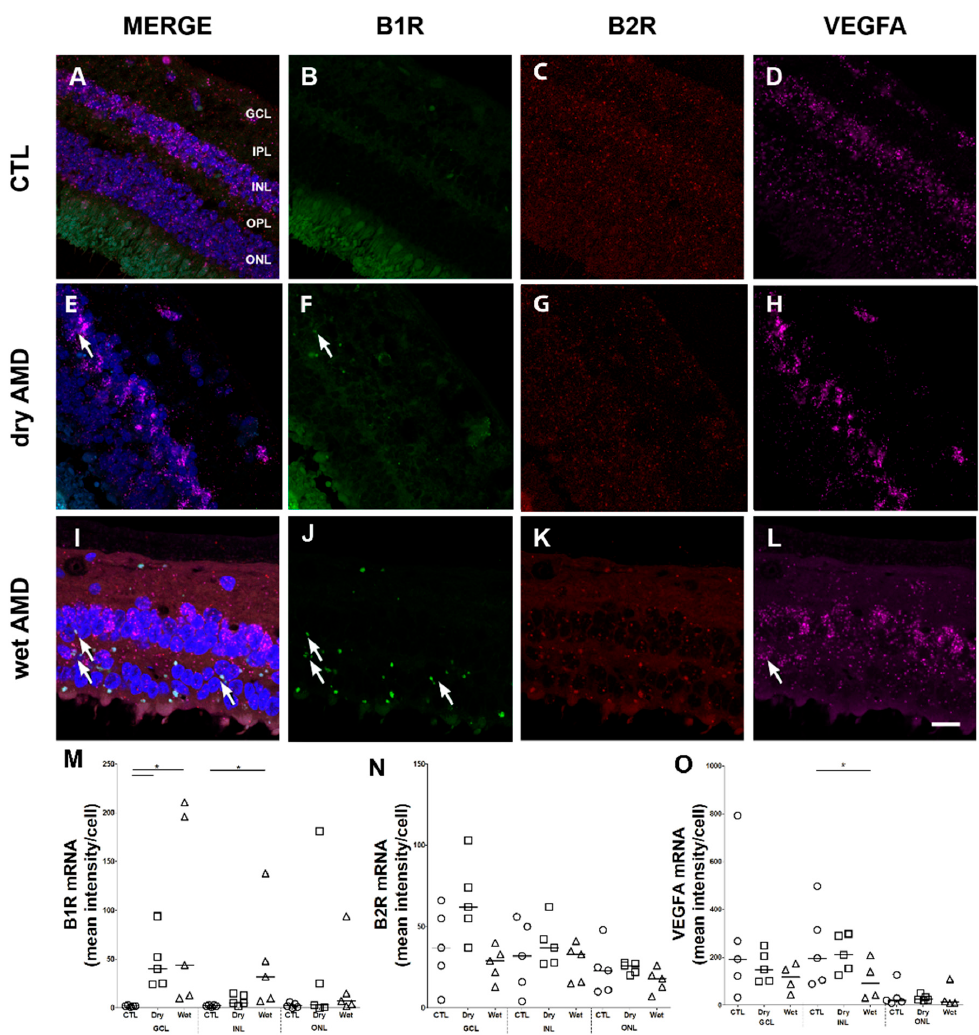
Figure 1. B1 and B2 receptors (B1R, B2R) and vascular endothelial growth factor A (VEGFA) mRNA expression in human retinae ( A – L ). Microphotographs showing the mRNA labeling for B1R (green; B , F , J ), B2R (red; C , G , K ) and VEGFA (purple; D , H , L ) in the control (CTL), dry age-related macular degeneration (AMD) and wet AMD retinae. Sections are counterstained for 4 (cid:48) ,6-diamidino-2-phenylindole (DAPI; blue; A , E , I ), which labels cell nuclei. Note that B1R was partially colocalized with B2R in wet AMD in the outer nuclear layer (ONL), and B2R was also partially colocalized with VEGFA in the ONL, however, there was rare colocalization between B1R and VEGFA. Images were obtained at 40 × . Scale bar: 20 µ m. ( M – O ) Quantification of the mRNA (mean fluorescence intensity / cell) of B1R, B2R and VEGFA in the di ff erent layers of the retina. Data are mean ± SEM of values obtained from five retinae per group and four zones per retina. * p < 0.05 AMD compared with control. CTL: control (O), Dry: dry AMD ( (cid:3) ), Wet: wet AMD ( (cid:52) ), GCL: ganglion cell layer, IPL: inner plexiform layer, INL: inner nuclear layer, OPL: outer plexiform layer, ONL: outer nuclear